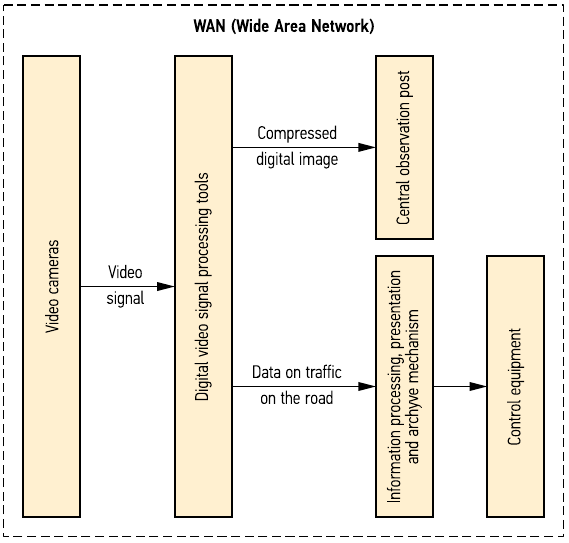
Fig. 1. The principle governing operation of intelligent transport management